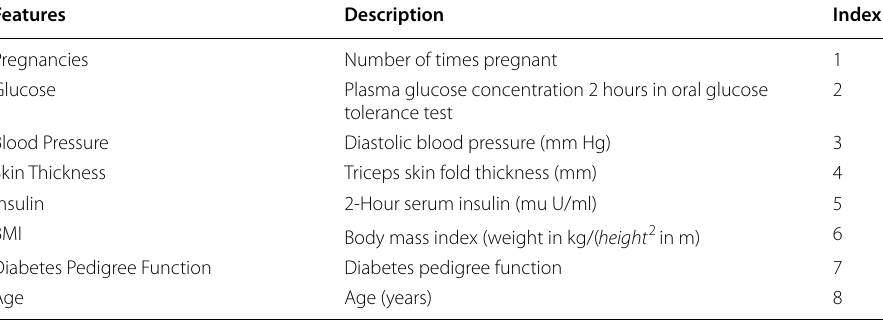
Table 2 Features used in this method to predict diabetes patient in strong situation